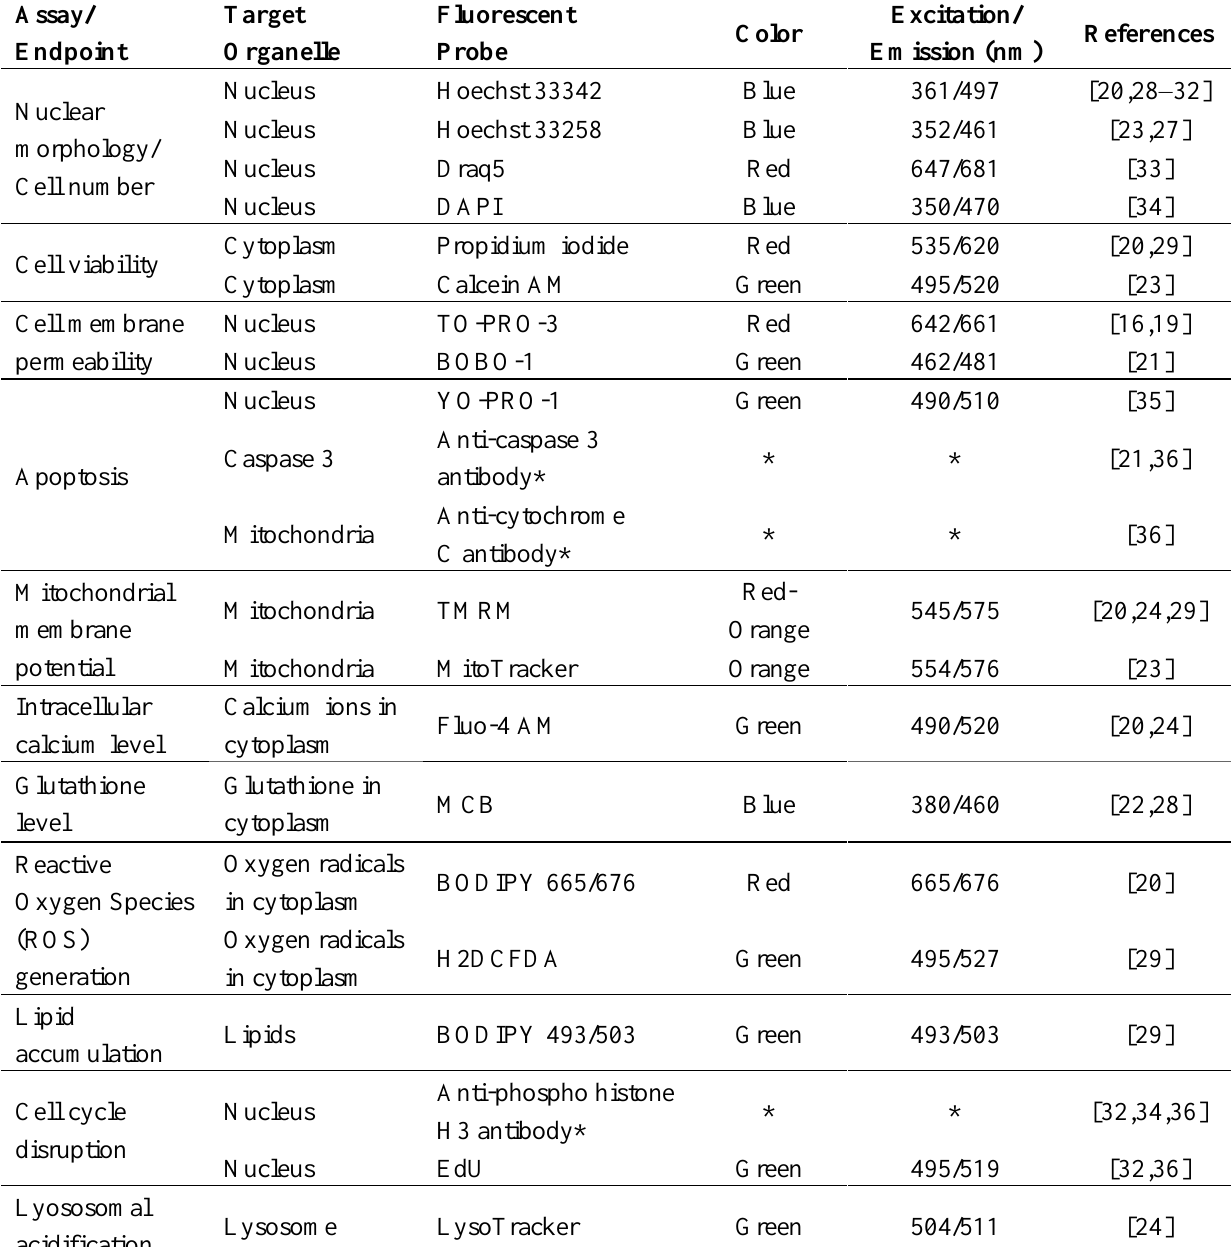
Table 1. Commonly used fluorescent probes for various high content imaging (HCI)